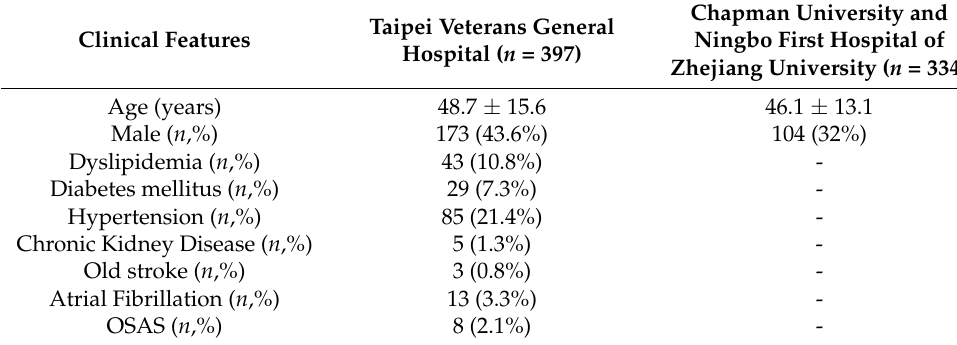
Table 3. Clinical characteristics of the study